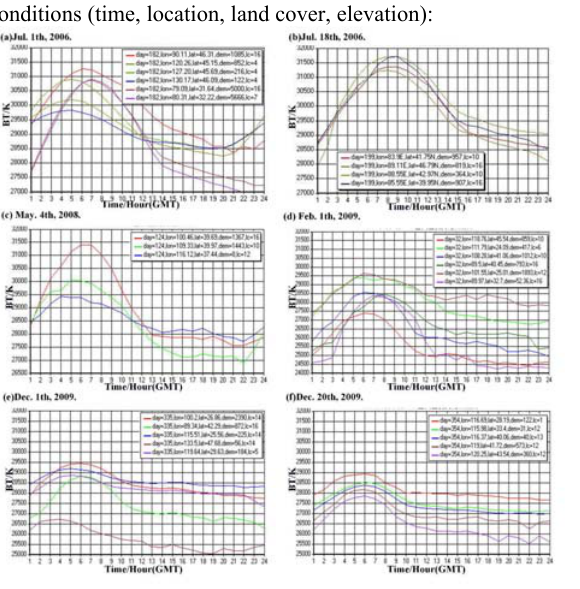
Figure 2. Temperature change curves in China area: day is the date, lon is the longitude, lat is the latitude, dem is the elevation above sea level and lc is the land cover type as defined in